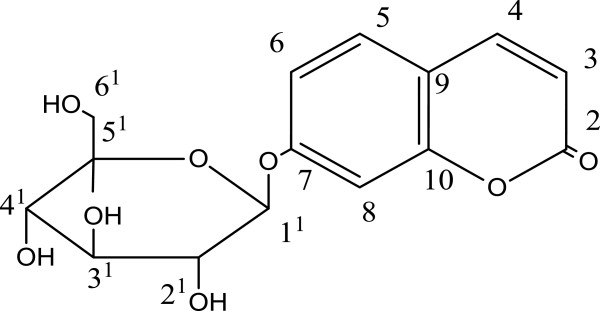
Structure of umbelliferone β-D-galactopyranoside.